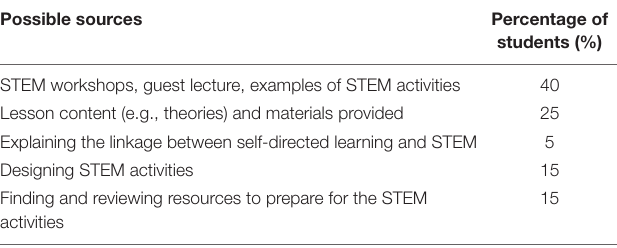
TABLE 3 | Possible sources of having conceptual changes in STEM